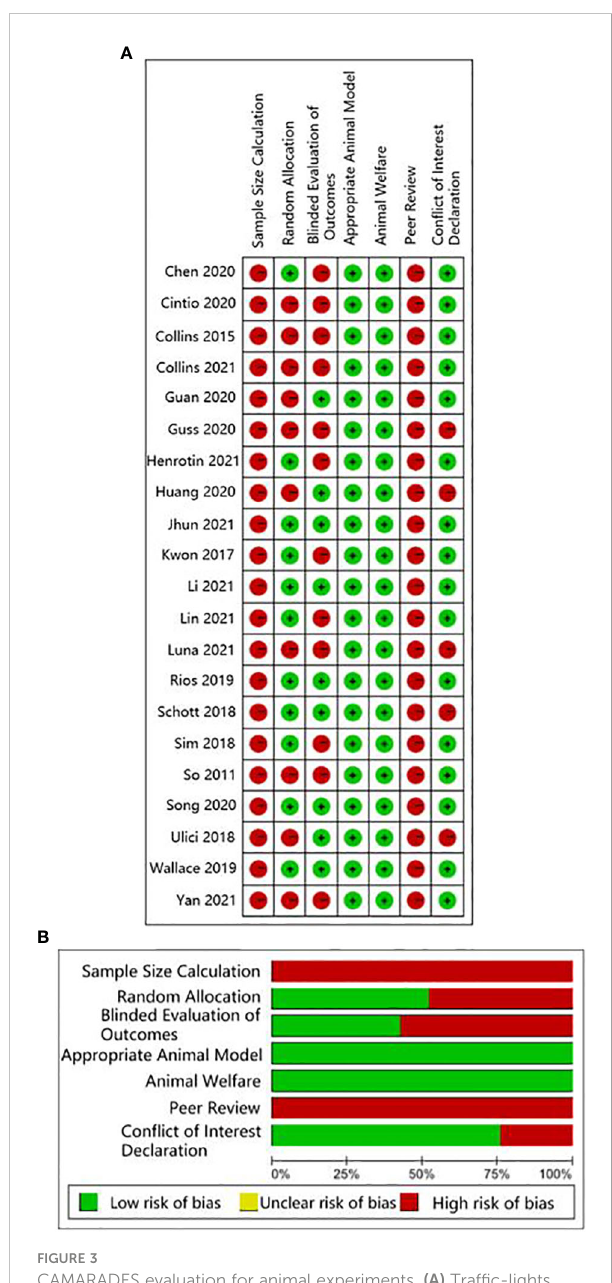
FIGURE 3 CAMARADES evaluation for animal experiments. (A) Traf fi c-lights plots; (B) Weighted bar